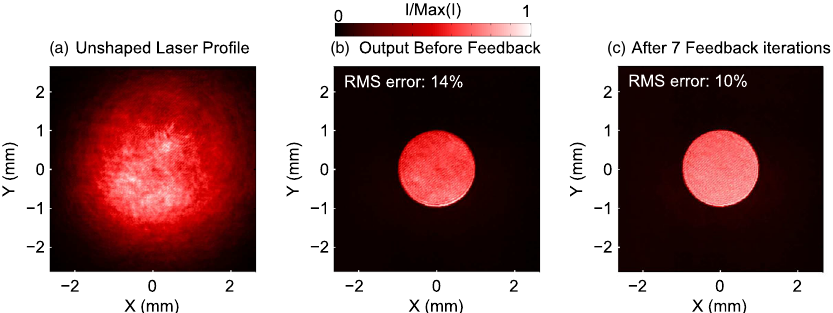
FIG. 3. (a) The initial near-Gaussian unshaped laser profile, U . (b) Shaped profile, a 2 mm diameter flattop, prior to feedback, I 0 . (c) After seven feedback iterations, the rms error is reduced to 10%. Each image is scaled to its respective